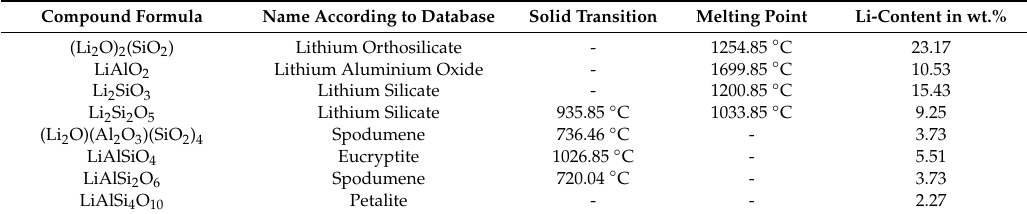
Table 2. Theoretical transition temperatures of selected lithium compound and lithium content according to FactSage TM [30].